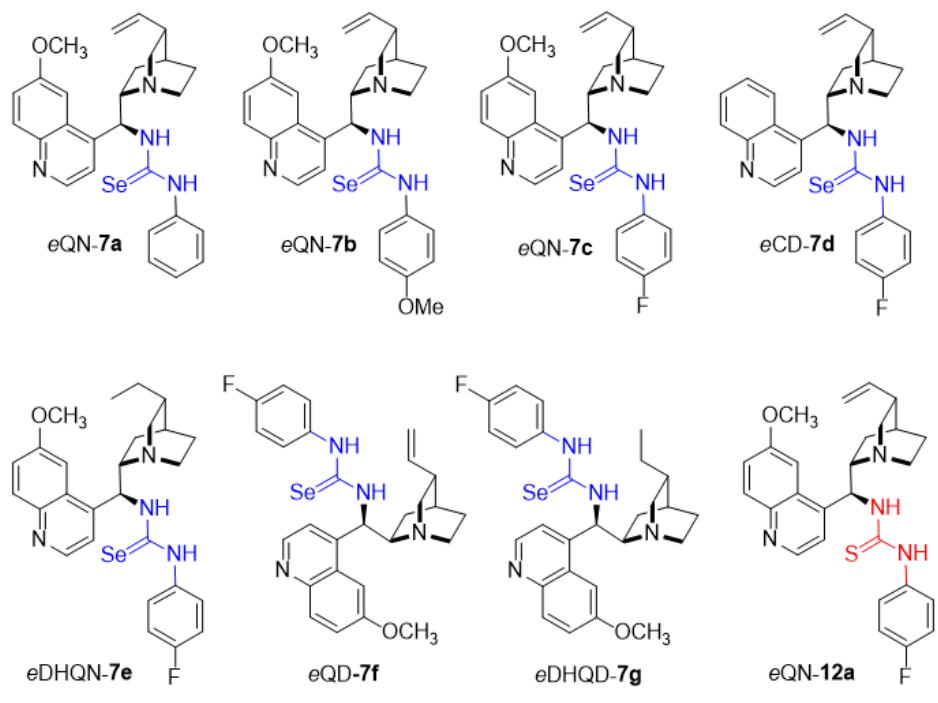
Figure 1. Structures of the Cinchona -based selenoureas.